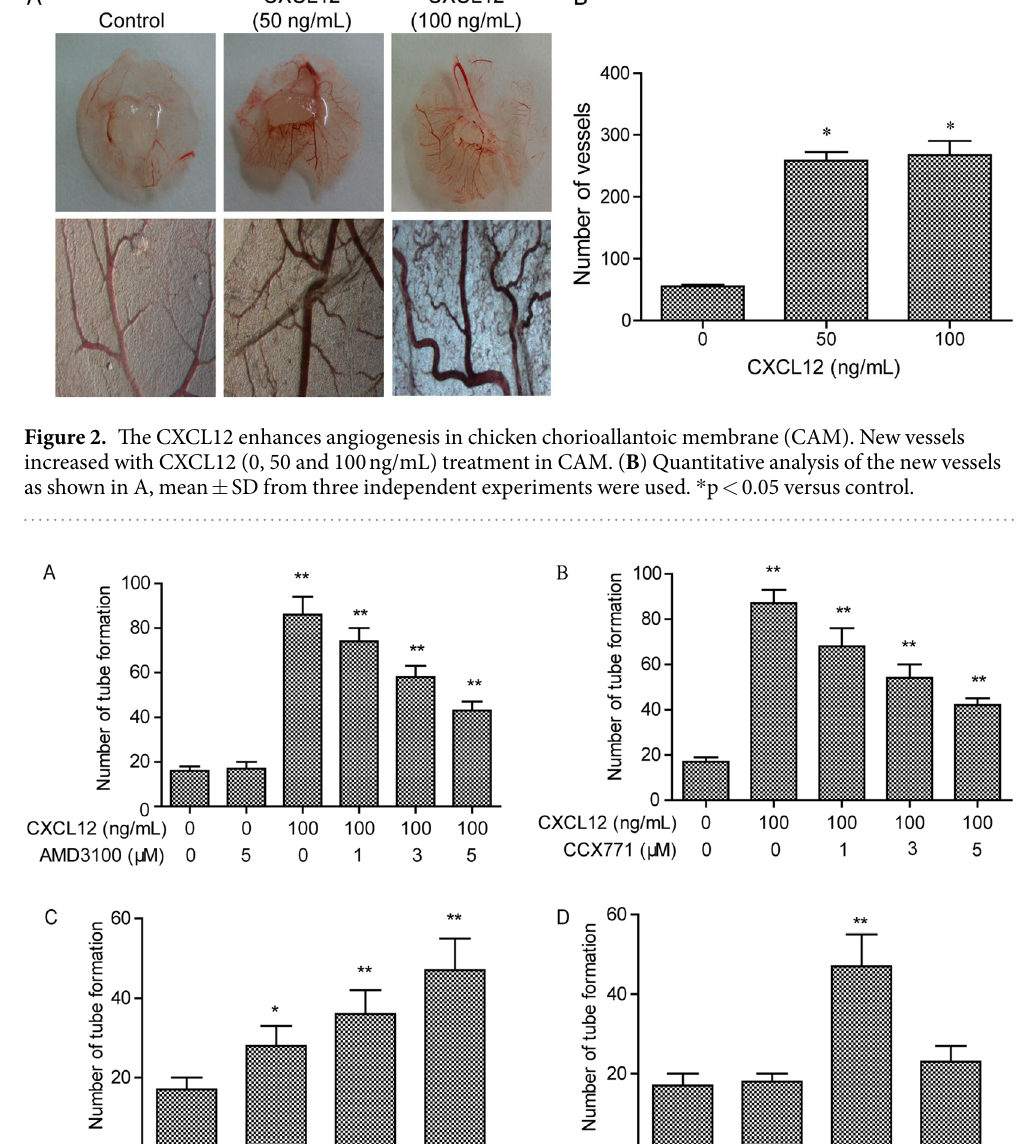
CXCL12-induced directional cell polarization is dependent on CXCR7 and CXCR4.